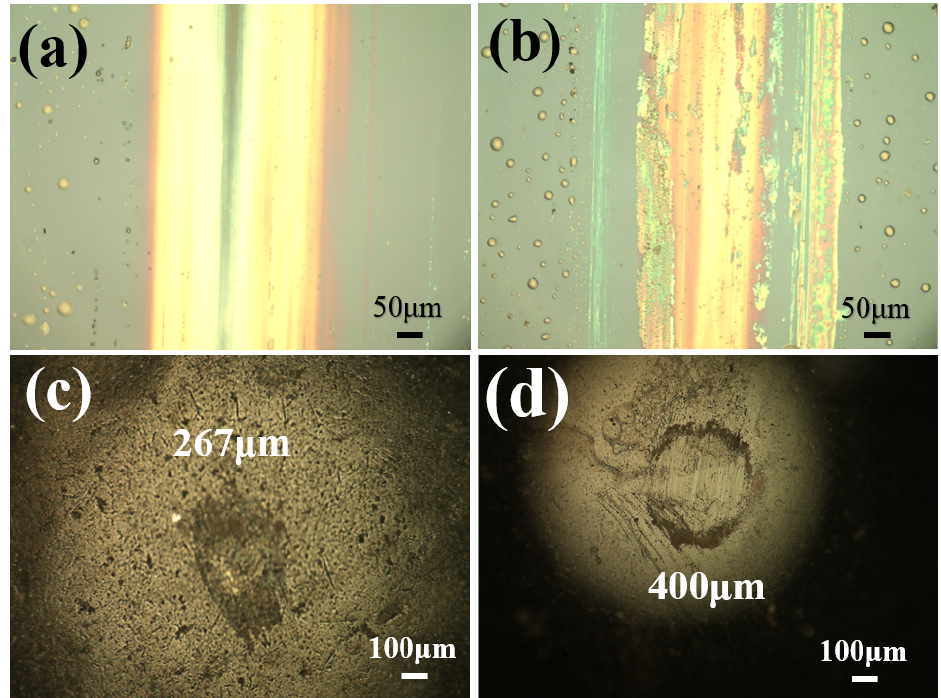
Figure 6. The morphology of the worn scar for the IL/G composite films and corresponding steel balls: IL/0.1G ( a , c ) and IL/0.3G ( b , d